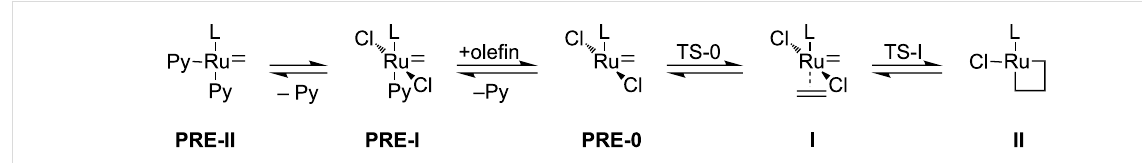
Scheme 1: Mechanism of the olefin metathesis.